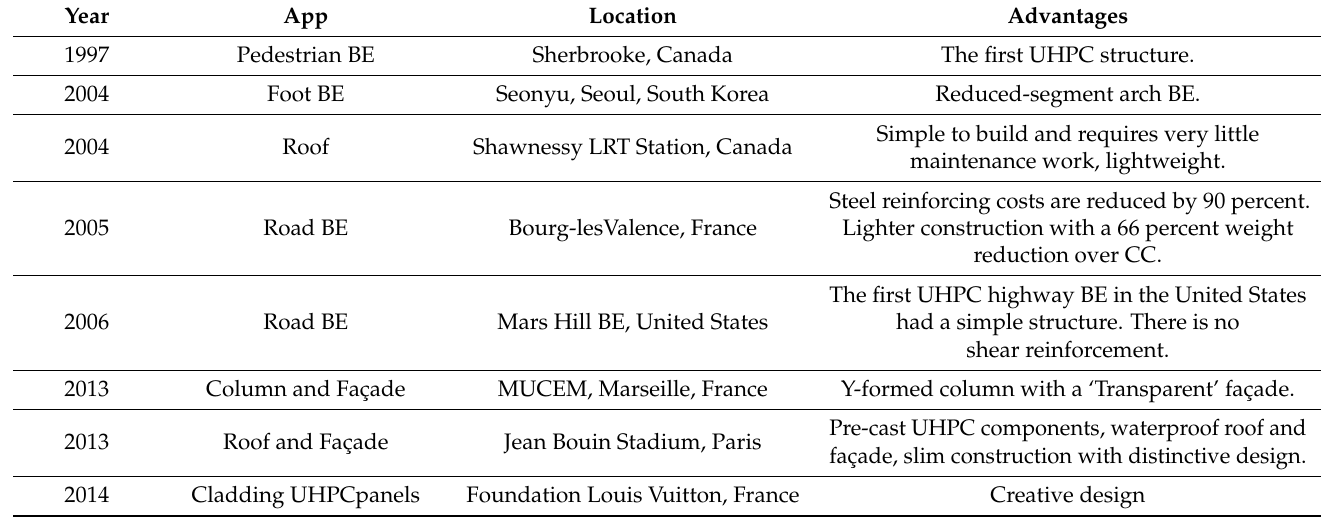
Table 2. Completed UHPC projects worldwide [ 53 ].